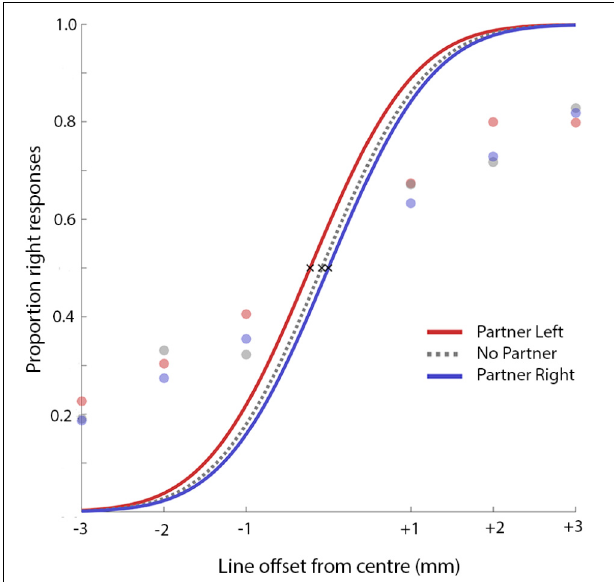
FIGURE 3 | Mean line bisection thresholds across partner locations. Error bars represent within-subject 95% confidence intervals (Cousineau, 2005; Morey, 2008). Note that thresholds are not different based on partner position.